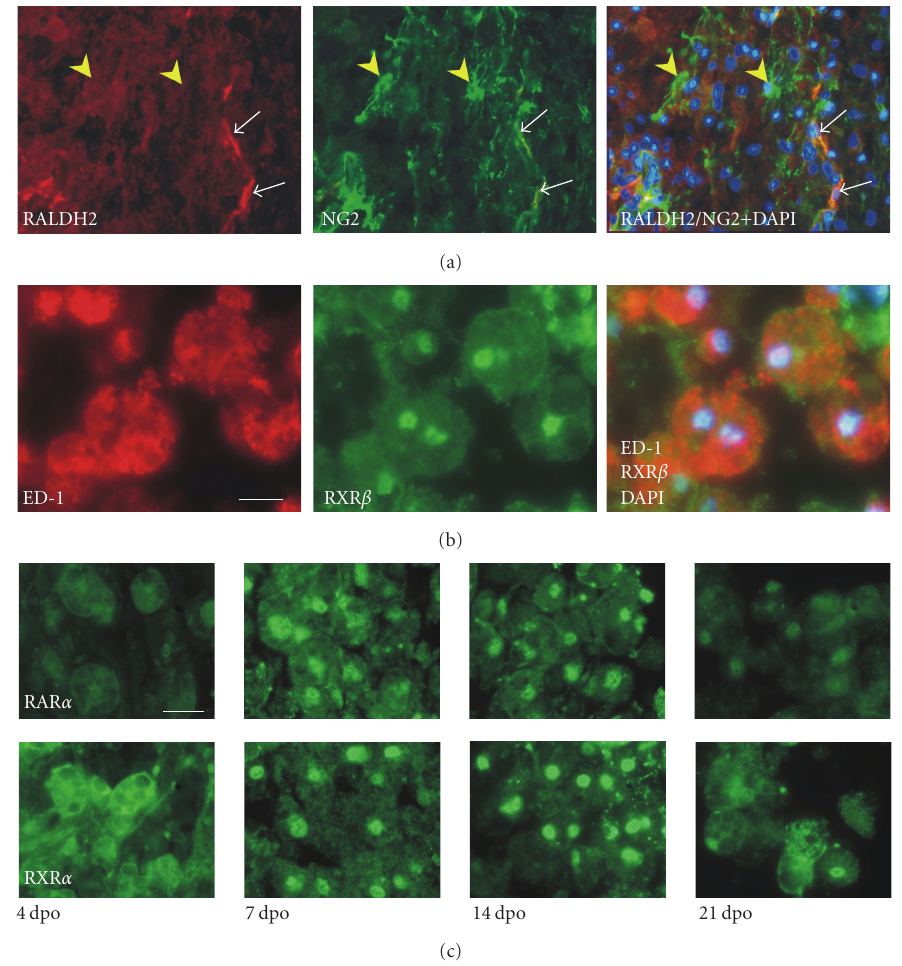
Figure 1: Retinoic acid synthesis and nuclear translocation of RAR/RXR after spinal cord injury. (a) Double immunostaining of rat spinal cord sections shows RALDH-2 immunoreactivity (red) in a subpopulation of NG2-positive glia (green) 7 days after contusion injury. RALDH2/NG2 expressing cells were only detected in the vicinity of the lesion site, many NG2 cells do not contain the RA-synthesizing enzyme (yellow arrow heads). White arrows point to DAPI-stained cell nuclei of RALDH2/NG2 cells in superimposed photographs. (b) At 7 dpo, ED1-positive macrophages at the lesion site express RXR β in their cell nuclei. (c) SCI-induced transient translocation of RAR β and RXR α from the cytosol into the nuclei of activated macrophages/microglia. All scale bars are 20 μm (sources: [12,